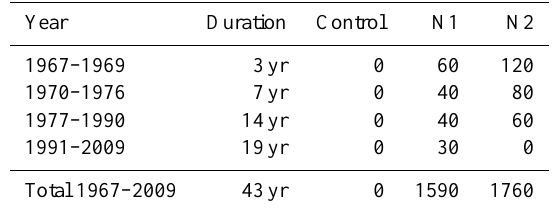
Table 1. Nitrogen addition rates (kgNha − 1 yr − 1 ) and total amount of N added 1967–2009 (kgNha − 1 ) at